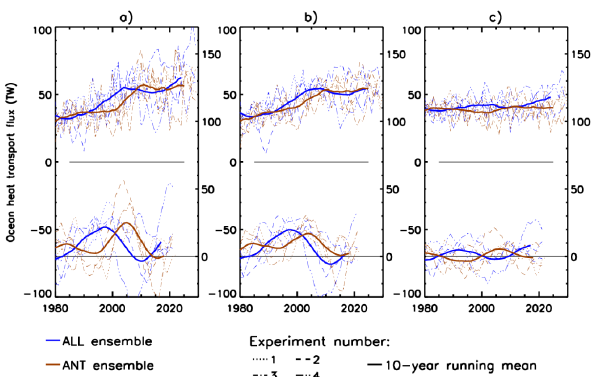
Fig. 8. Ocean heat transport into the Arctic Ocean in the HadGEM1 runs. Showing (a) OHT =∫ T ocn u ocn · d S , as calculated in the heat budget; (b) as in (a) , with velocity fields replaced with the time mean; (c) as in (a) , with temperature fields replaced by the time mean. Each figure shows ocean heat transport (top sets of lines, left scales) and 15-yr running gradients (bottom sets of lines, right